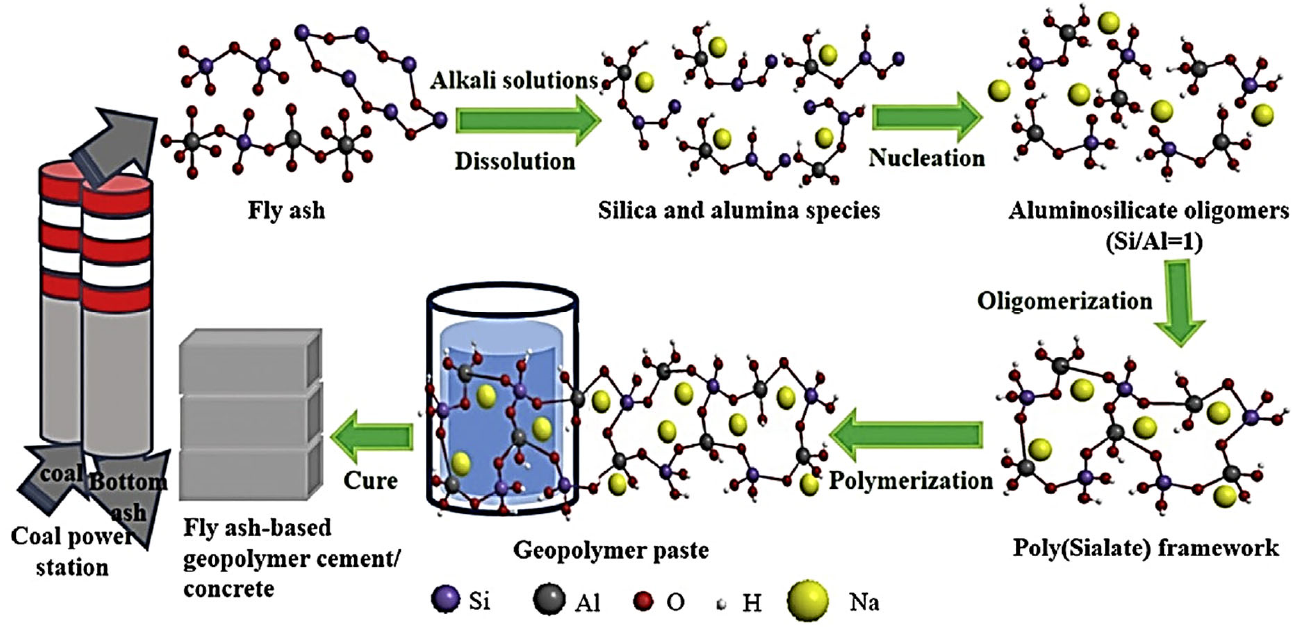
Figure 11. The schematic diagrams illustrate the pathway from FA to FA-GP concrete. Adapted from [90].